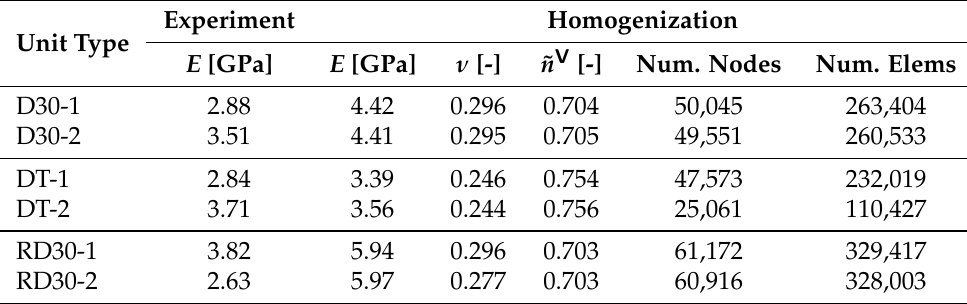
Table 8. Effective elastic properties of trabecular structures from homogenization.